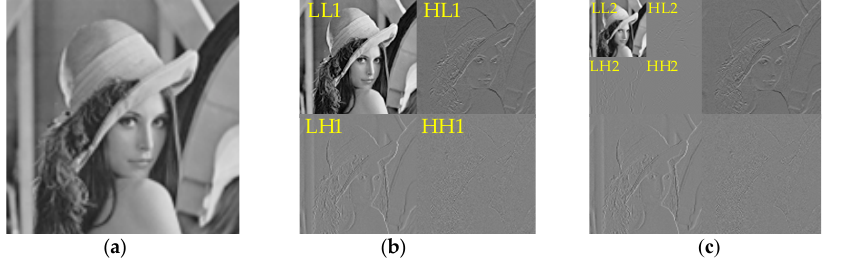
Figure 2. The decomposition process of 2-D DWT. ( a ) Original image, ( b ) one-level decomposition image; ( c ) two-level decomposition image.